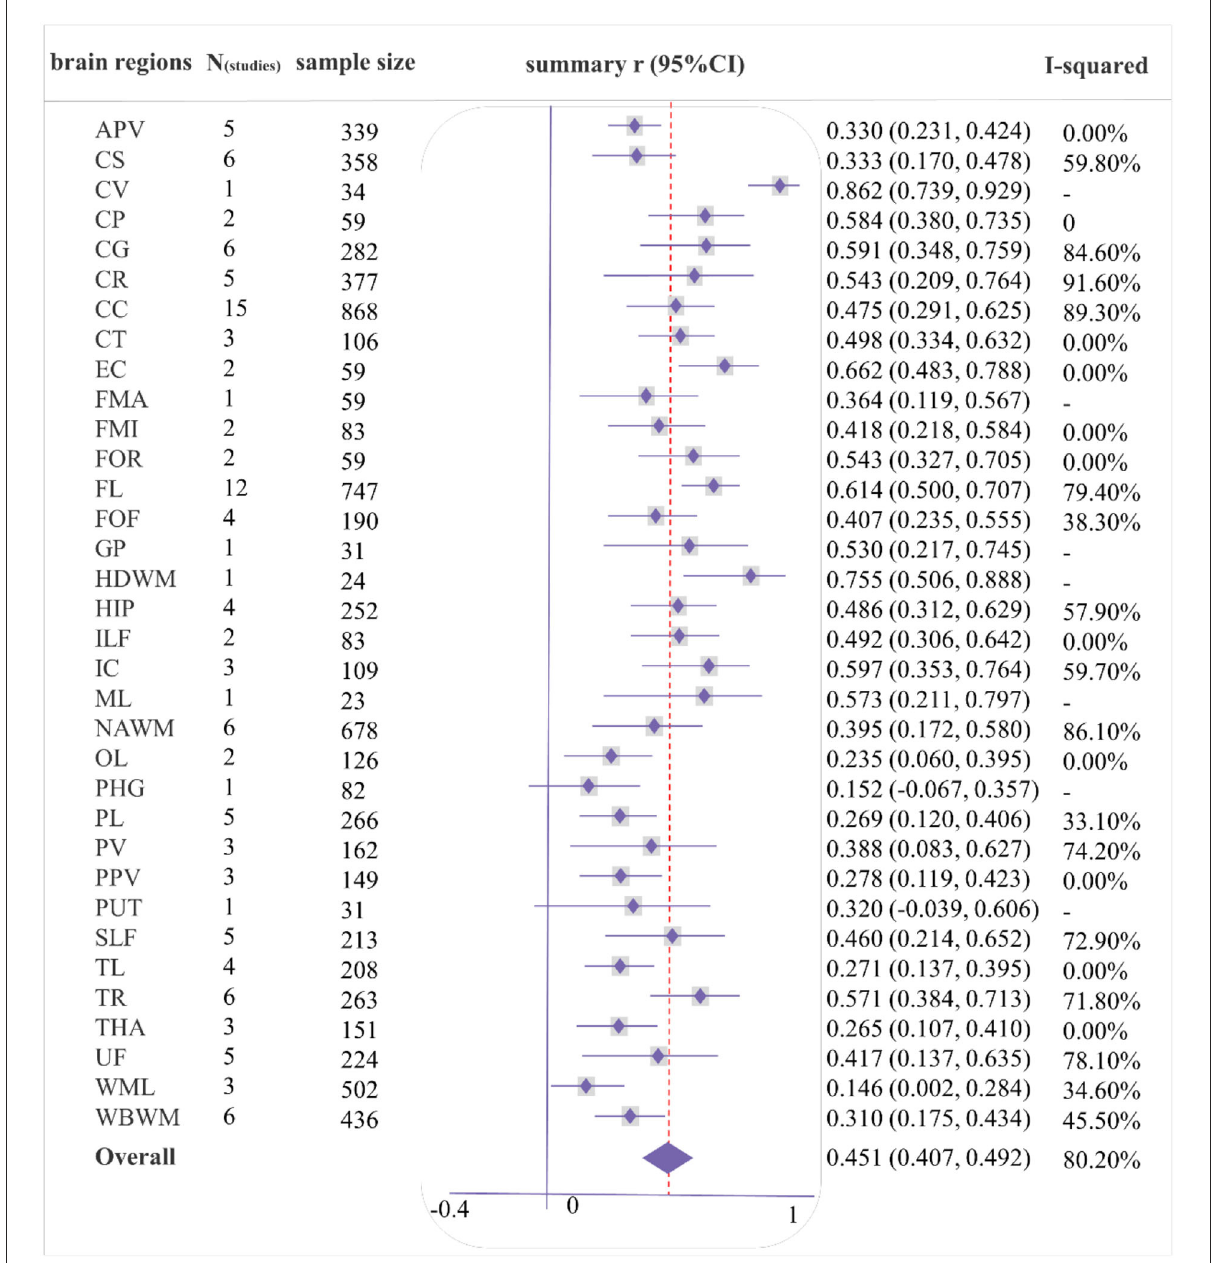
FIGURE2 Forest plot of correlations between fractional anisotropy (FA) and general cognition by different brain regions. Summary of abbreviated words in Supplementary Table S5, the following figures are the same as above.